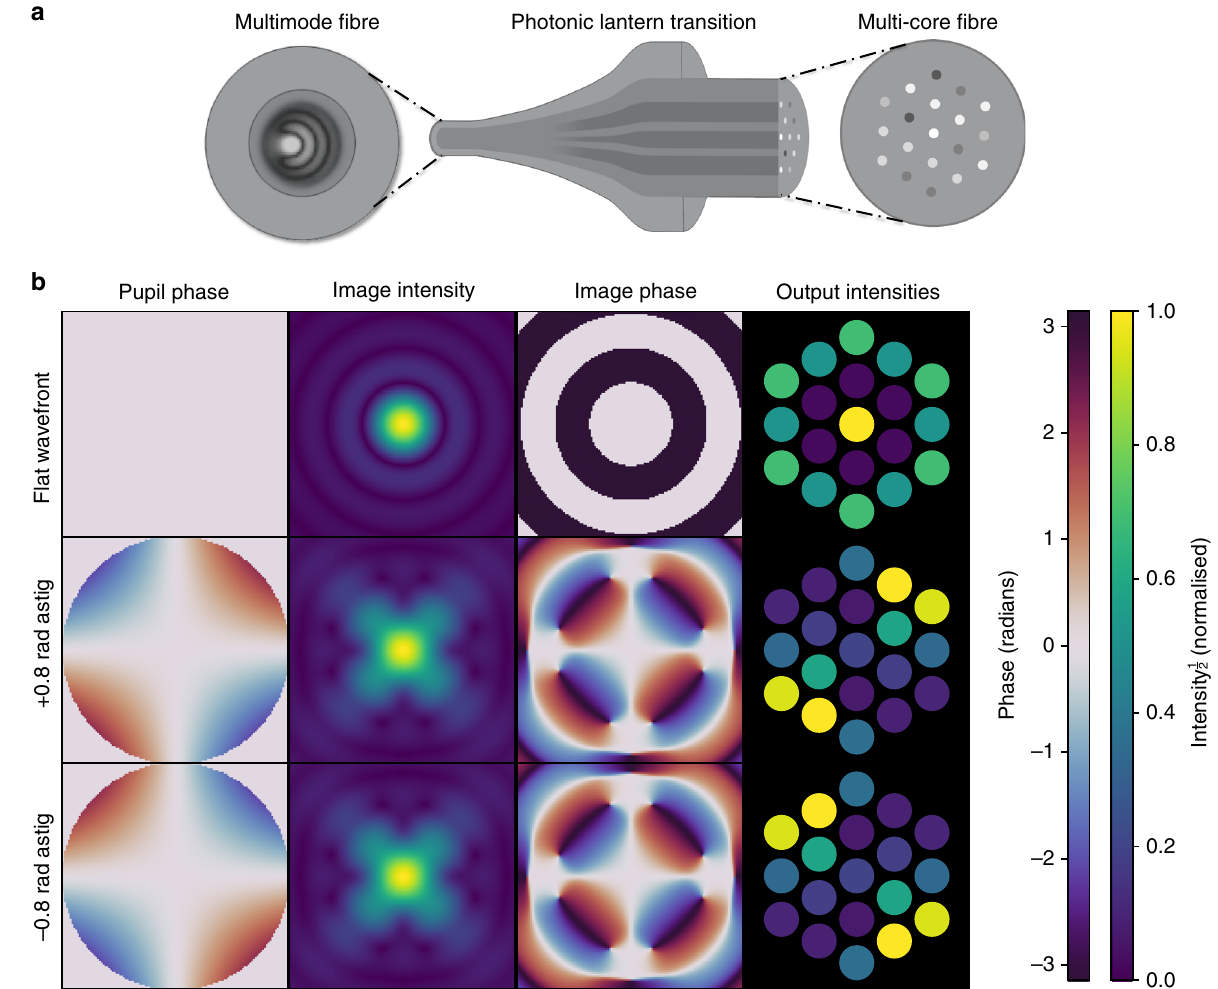
Fig. 1 Non-degenerate response of the photonic lantern wavefront sensor to focal plane phase. a Schematics of a multi-core photonic lantern showing how the phase and intensity of the input fi eld into the multimode fi bre end-face evolve into an array of uncoupled single-mode cores with different intensities. b The results of three RSoft simulations demonstrating the concept of the photonic lantern wavefront sensor, and its ability to measure both amplitude and phase. The fi rst column shows the phase of the wavefront, and the second and third columns show the intensity and phase of the resulting PSF respectively. The fourth column shows the intensities of the 19 single-mode outputs of the photonic lantern, when the corresponding PSF is injected. In the fi rst example ( fi rst row) a fl at wavefront is used. In the second and third rows, astigmatism with an amplitude of 0.8 radians, but with opposite signs, is introduced. This results in identical intensity structure in the image plane (2nd column), and so could not be distinguished with an imaging sensor. However the (usually un-measured) phase in the focal plane (3rd column) shows the difference between the two astigmatism terms, which is successfully measured by the photonic lantern (as shown by the different set of outputs from the lantern, in the 4th column). Simulations are performed at a wavelength of 1550 nm. Intensities are plotted with a square-root stretch to better show faint